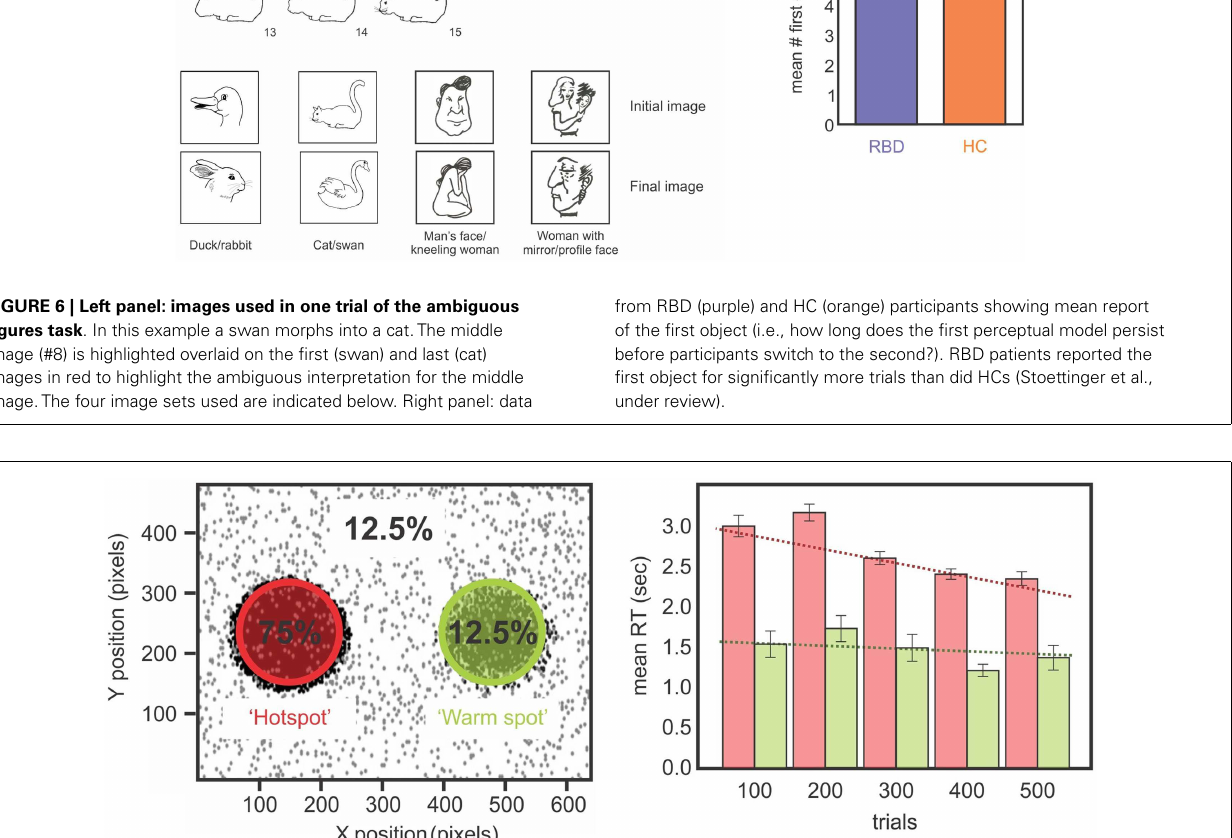
called the warm spot. Right panels show the chronic neglect patient’s RT for the hot spot and the warm spot.There is a difference on the RT for the left and right-sided targets over the sessions.The patient improved his RT over the sessions for the targets presented on the hotspot, which was not the case for the targets presented on the warm